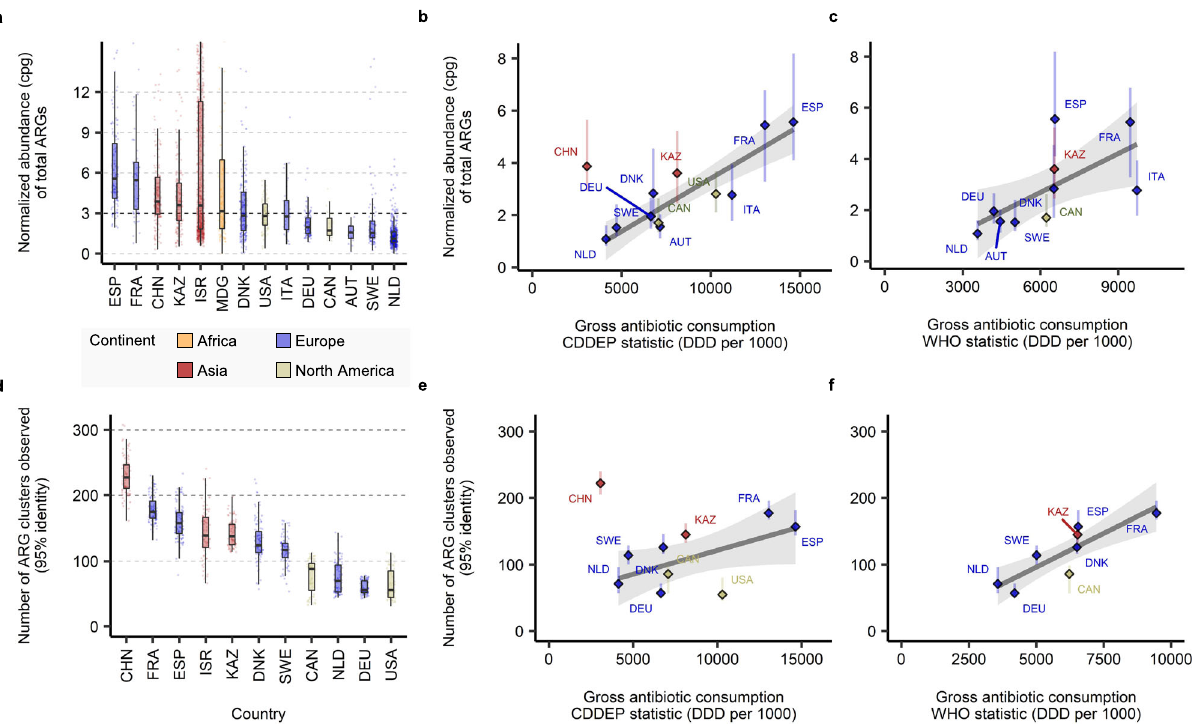
Fig. 2 | Correlation between median diversity and abundance of ARGs in healthy adult gut metagenomes in a country and antibiotic consumption rates.a MediantotalgutARGabundance(cpg)inhealthyantibioticfreeadultsfor countries with>10 samples. b , c Correlations between median total ARG abun- dance and the per capita rate of antibiotic consumption (DDD per 1000), using CDDEP consumption statistics in ( b ) and WHO in ( c ). Pearson ’ s correlation tests gave r =0.89, p =0.00023 for CDDEP ( b ) and r =0.65, p =0.040 for WHO ( c ), excluding China from the CDDEP correlations. d Median rare fi ed (100±10Gbp subsamples) ARG_cluster95 richness across countries. e , f Correlations between ARG_cluster95 richness per 100Gbp and the per capita rate of antibiotic con- sumptionforCDDEP( e )andWHO( f )estimates.Pearson ’ scorrelationtests r =0.57, p =0.11 for CDDEP ( e ) and r =0.85, p =0.0073 for WHO ( f ), excluding China from the CDDEP correlations. Vertical lines range from the 25th percentile to 75th per- centile ( b , c , e , f ). Country-level ARG statistics are given in Table S3. Correlation